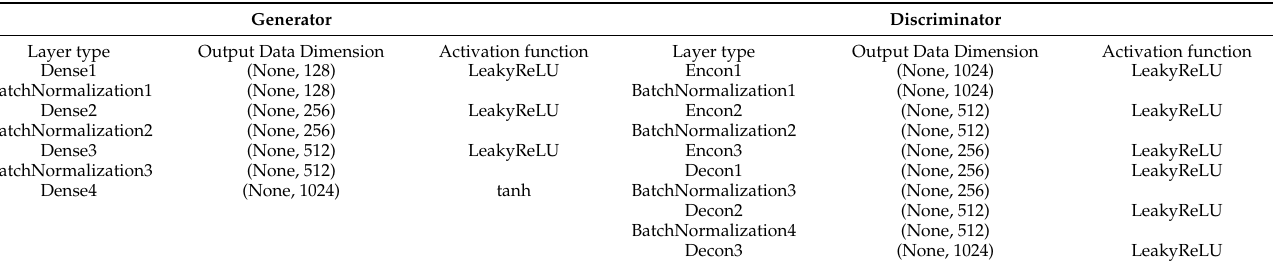
Table 2. One − dimensional EBGAN model